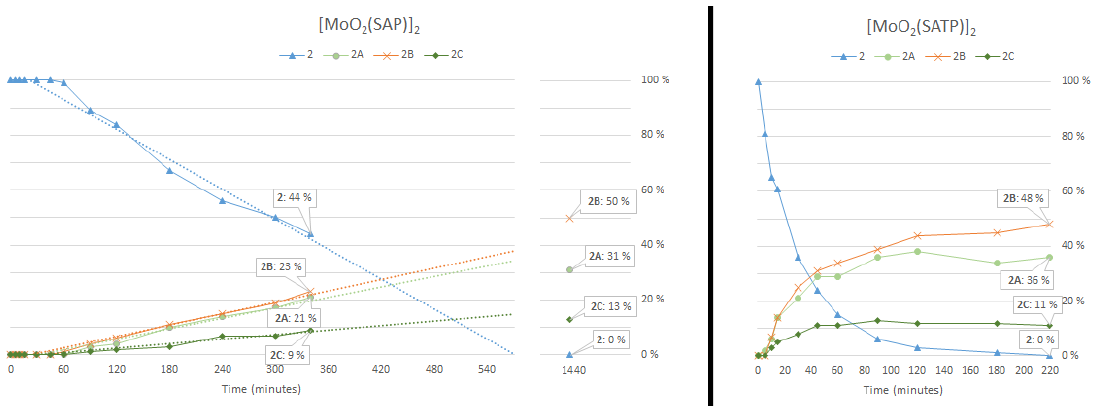
Figure 5. Kinetic studies on the reaction rate of 2 in toluene with 0.5 mol% dimeric precatalyst ([MoO 2 (SAP)] 2 to the left and [MoO 2 (SATP)] 2 to the right, and 5 equivalents of TBHP (70 wt% in water) at 80 °C. The trend lines (stacked lines) for [MoO 2 (SAP)] 2 suggested that the reaction had a quantitative conversion after 570 minutes.